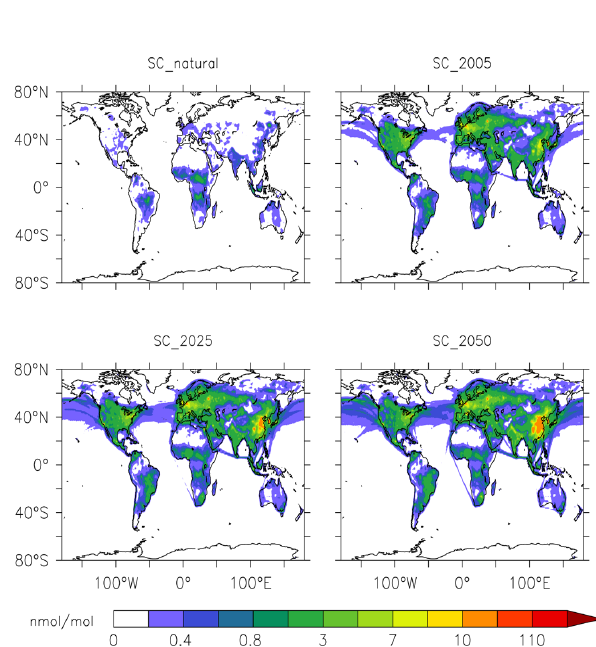
Fig. 5. Model calculated annual mean near-surface nitrogen dioxide in nmol mol − 1 from simulation SC natural , SC 2005 , SC 2025 and SC 2050